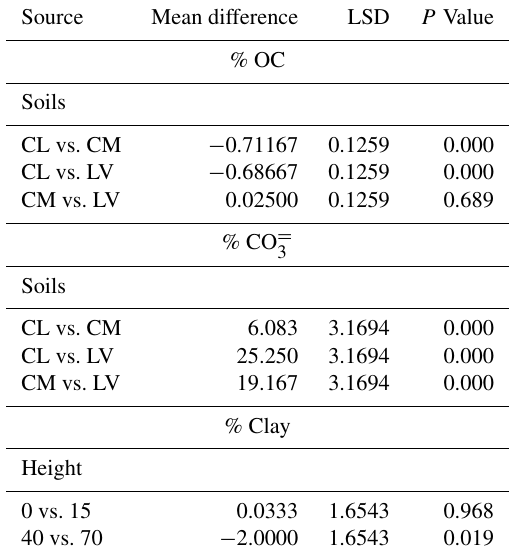
Table 4. Fisher’s least significant difference (LSD) post hoc anal- and 3 ysis for % OC, % CO = and % clay in Calcisols (CL), Cambisols 3 (CM) and Luvisols (LV)